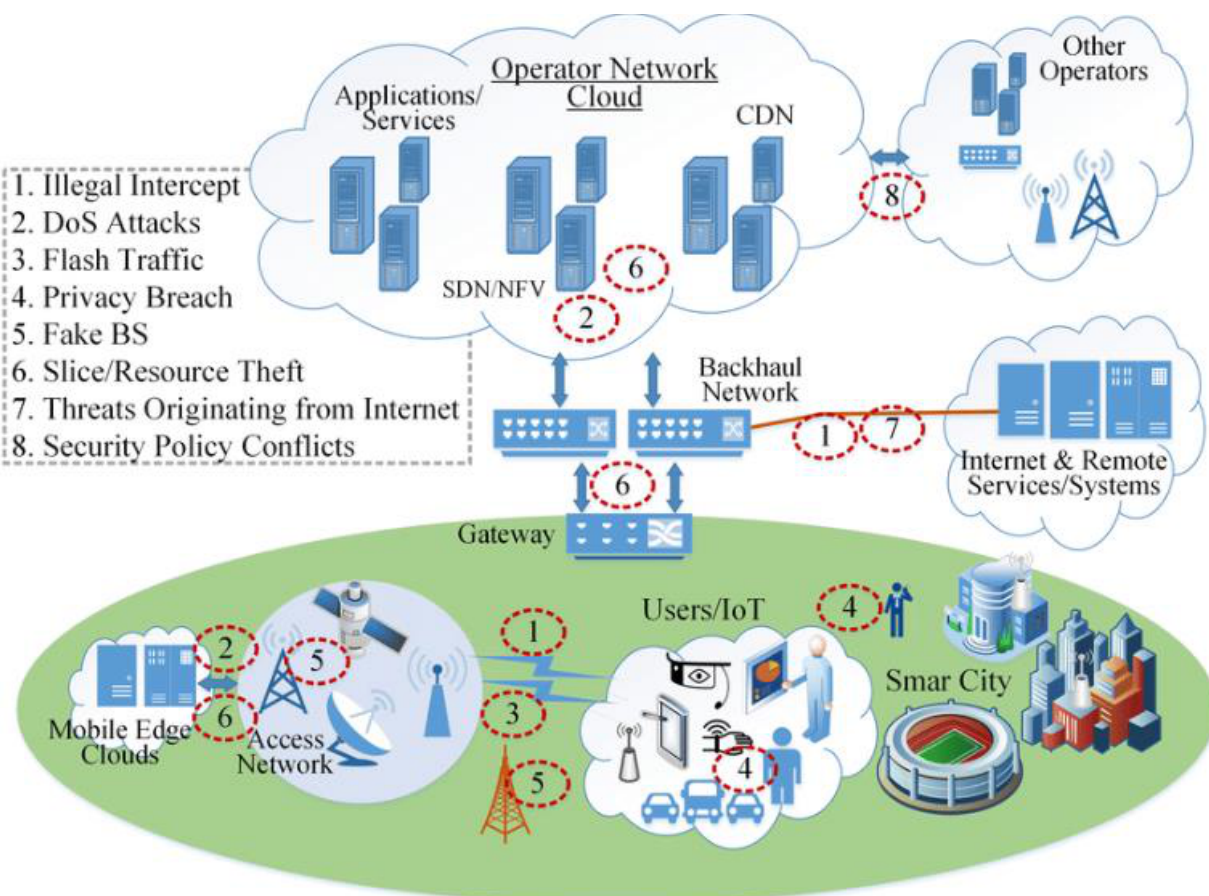
Figure 1. A 5g network and (8) eight security landscape